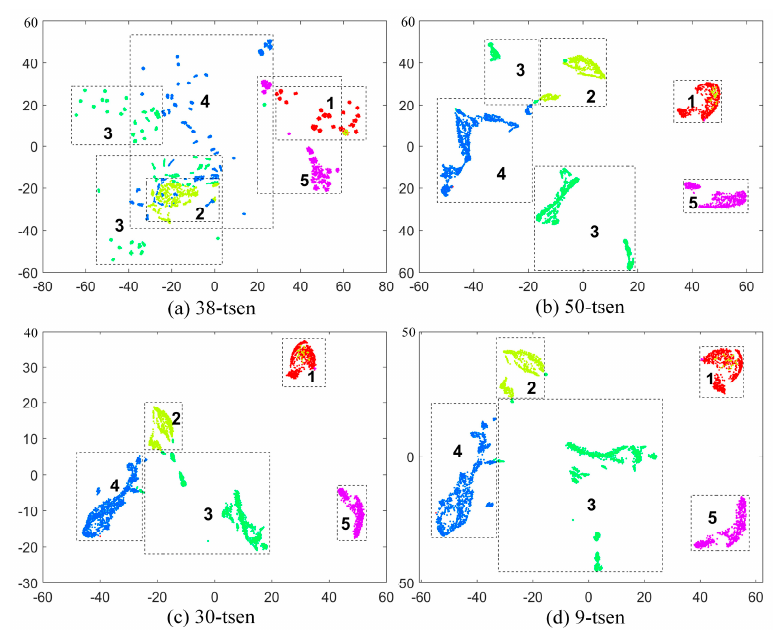
Figure 14. The t-SNE visualization classification diagram of di ff erent dimensional features. Figure 14. The t ‐ SNE visualization classification diagram of different dimensional features.